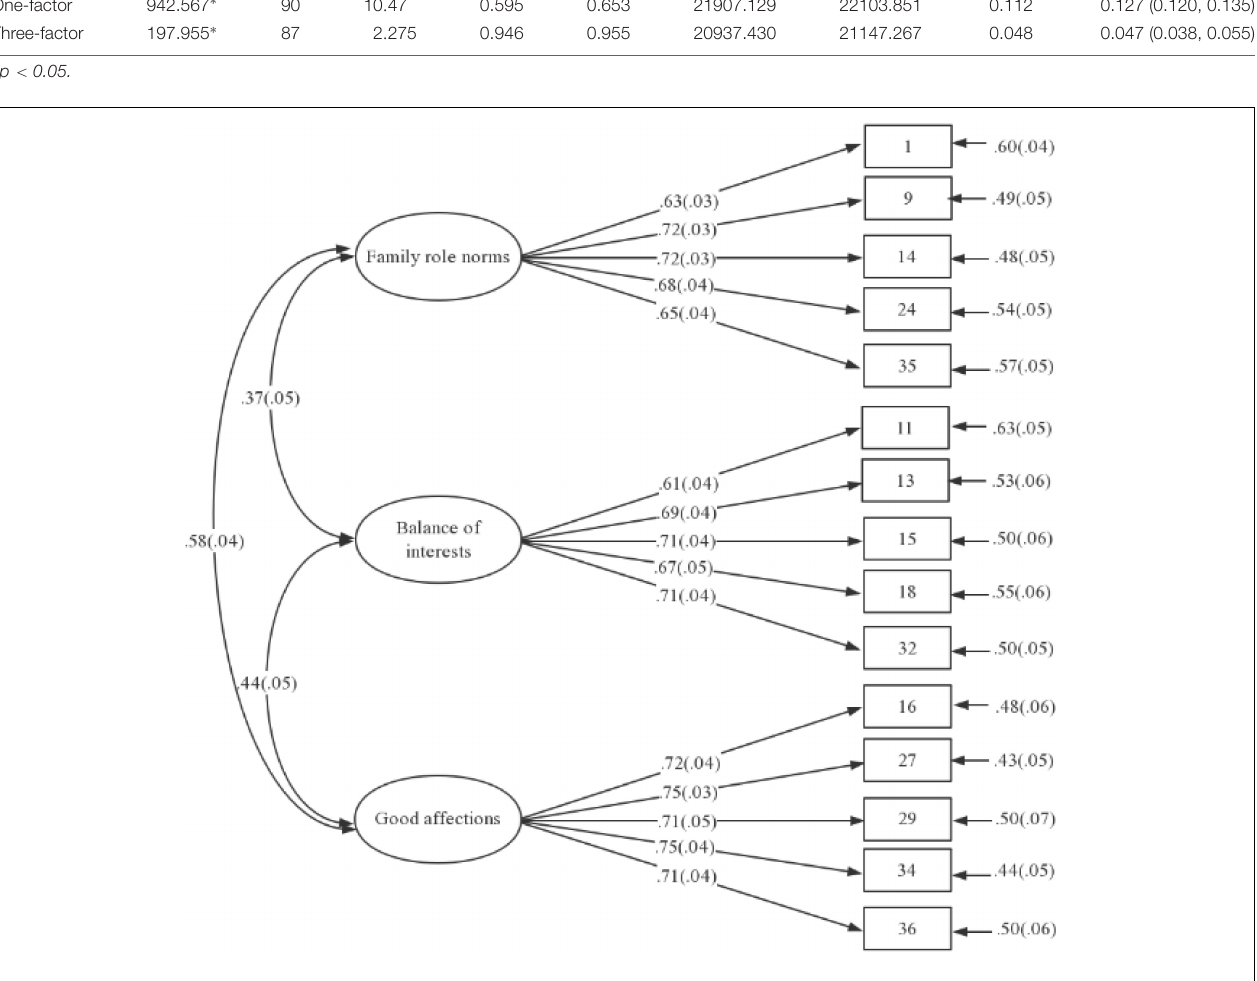
FIGURE 3 | Confirmatory factor analysis results on TFPS.